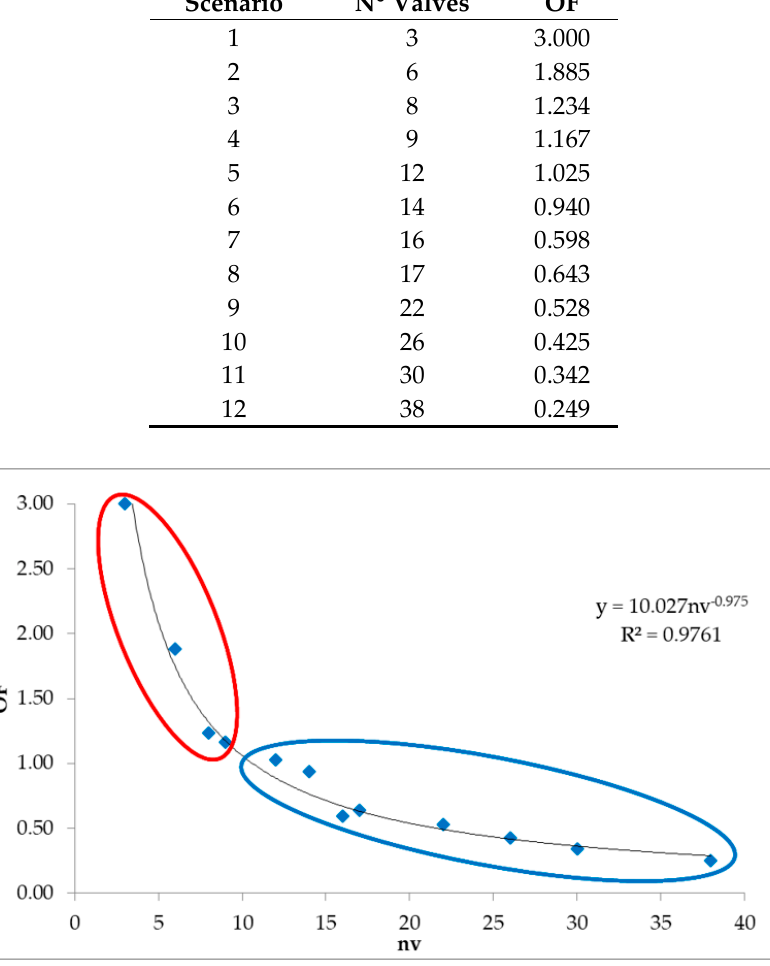
Figure 4. OF versus number of shut-off valves n v